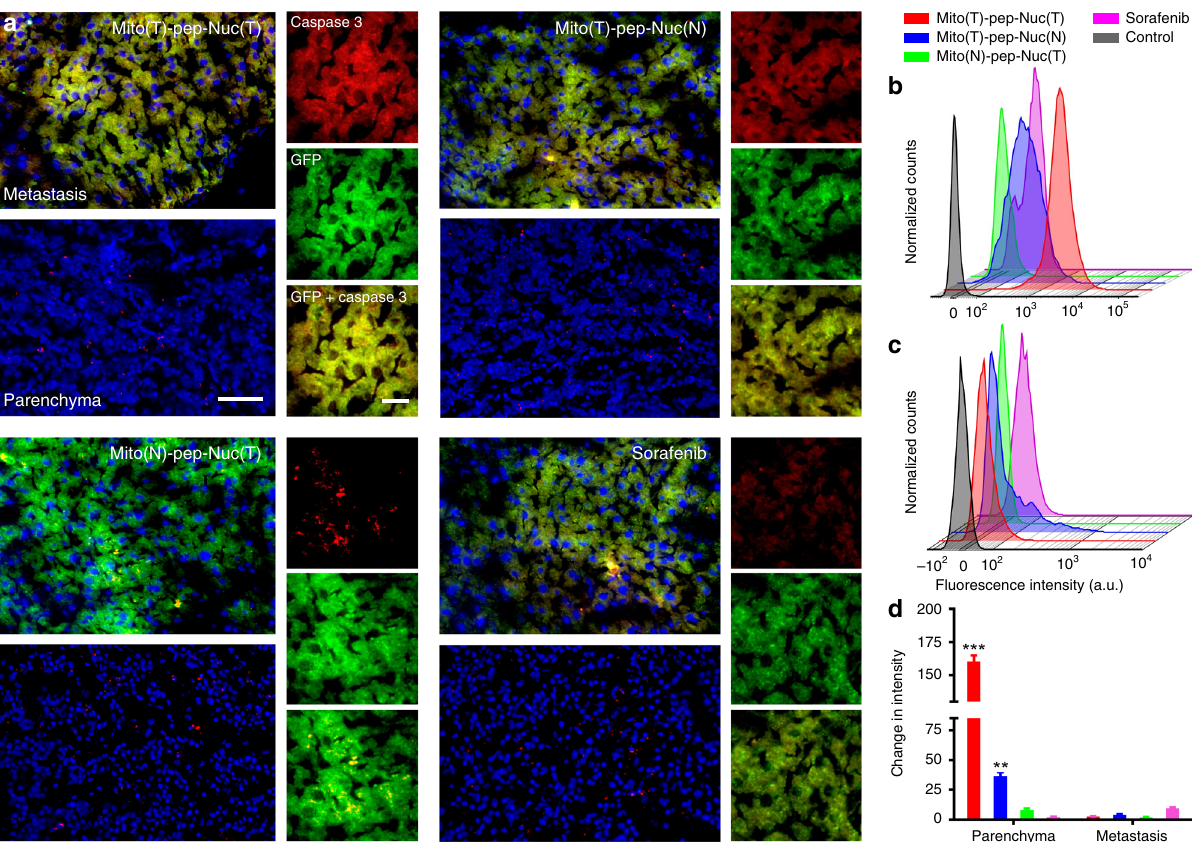
Fig. 6 Apoptosis pro fi les of liver metastatic lesion and parenchyma. a Immuno fl uorescence micrographs showing the expression of active Caspase 3 (labeled in red) in both metastasis (GFP positive, green) and pan-cancer, normal parenchyma (GFP negative). Scale bars: 80 μ m (left) and 20 μ m (right). b , c Flow-cytometry results showing the intracellular cleaved-PARP expression. The freshly harvested liver tissues from mice received different treatments were digested and sorted using fl ow-cytometry on the basis of the expression of the GFP protein, sequentially followed by fi xation, permeabilization, and staining with phycoerythrin (PE)-labeled cleaved-PARP antibody. d Changes of cleaved-PARP expression in b metastasis and c liver parenchyma. The averaged value of three independent tests was normalized to that of the control group; data are presented as mean ± s.e.m. ( n = 3). P values were calculated by one-way ANOVA (*** p < 0.001, ** p <